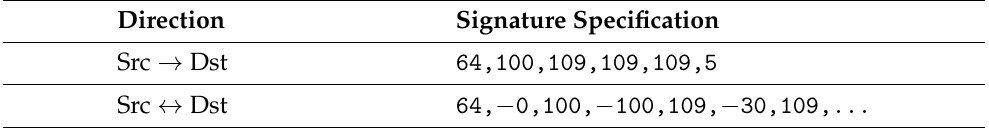
Figure 3. Illustration of packet payload size sequences within a network traffic capture of a login attempt to a web server. Table 1. Simple signature